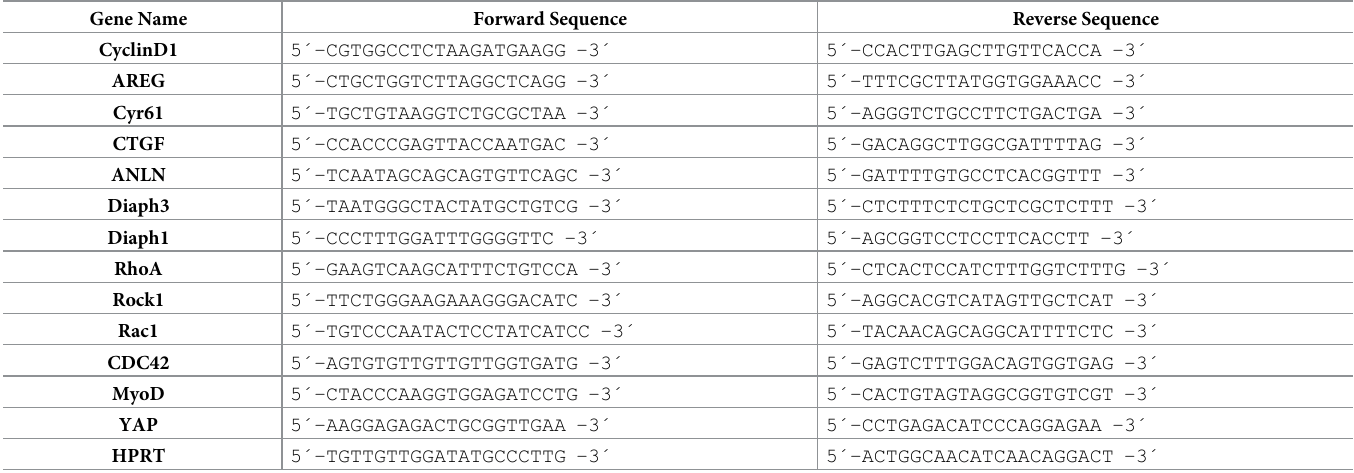
Table 1. List of primers used for